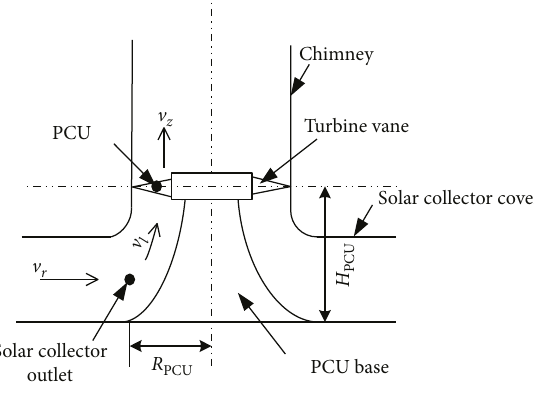
Figure 3: Cross-section of the